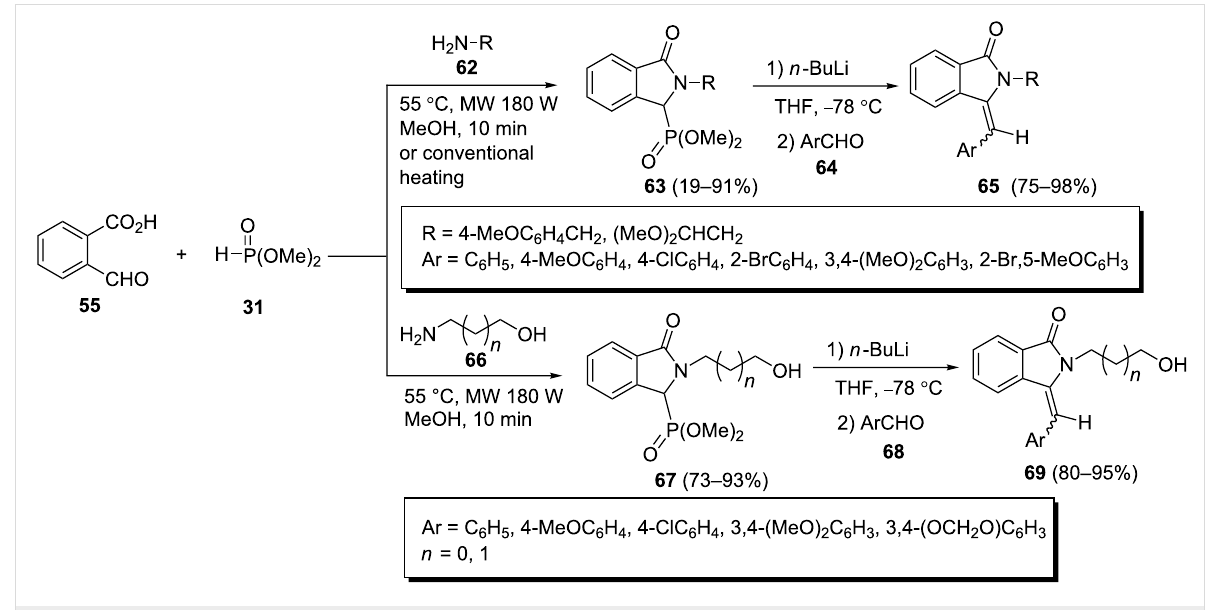
Scheme 16: The synthesis of 3-arylmethyleneisoindolin-1-ones through a Horner–Wadsworth–Emmons reaction of Kabachnik–Fields reaction prod- ucts.